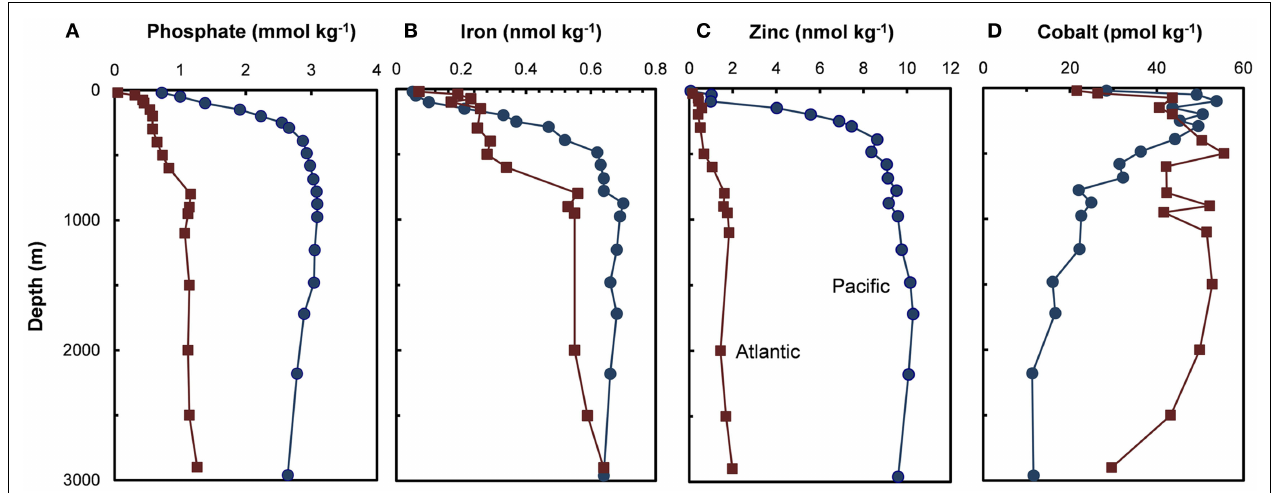
FIGURE 3 | Depth profiles for (A) phosphate and filterable concentrations of trace metal nutrients (B–D) (Fe, Zn, and Co) in the subarctic North Pacific Ocean (Ocean Station Papa , 50.0˚N, 145.0˚W,August 1987; Martin et al., 1989) and the NortheastAtlantic (40˚N, 20˚W, May 1989; Martin et al.,